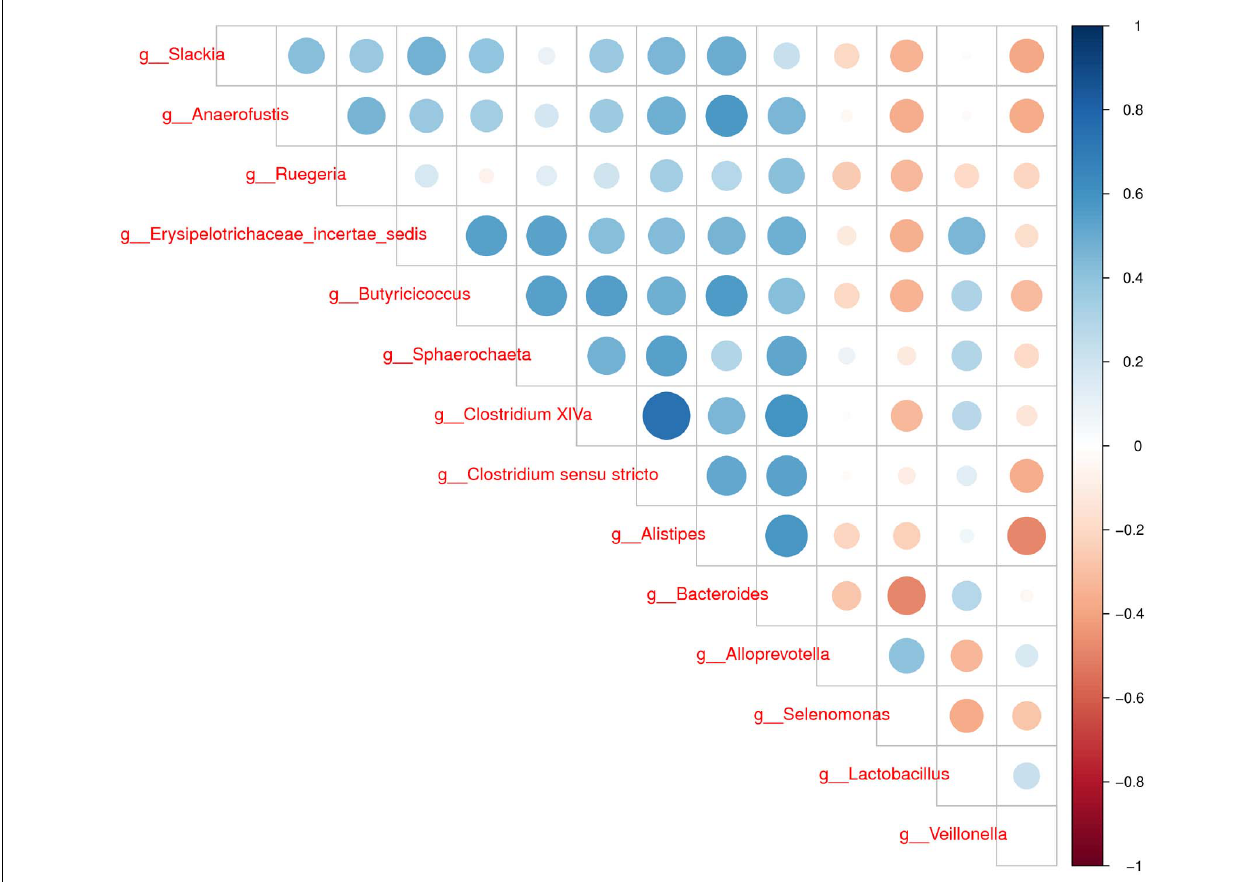
FIGURE 3 | Correlation analysis of fecal microbiota. Spearman correlation heat map among species. At all taxonomic levels, the correlation coefficients between species with differences in abundance Top 30 are positively correlated in blue and negatively correlated in red on the right. The darker the color, the stronger the correlation between species.